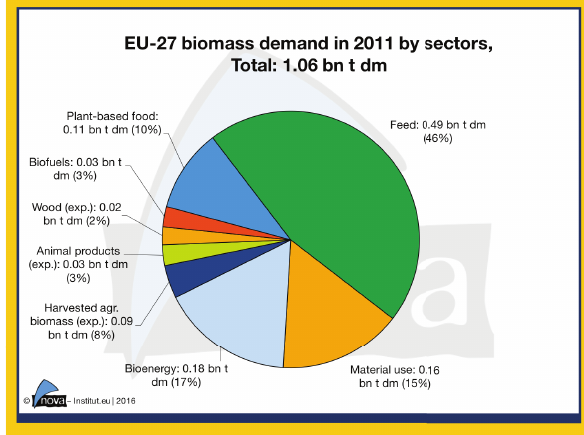
Figure 4: Biomass demand of the EU-27, 2011, by biomass sources Source Food and Agriculture Organization Corporate Statistical Database (FAOSTAT). Statistical database of the FAO. 2014. Available at http://faostat.fao.org/site/ 339/default.aspx (Last accessed March